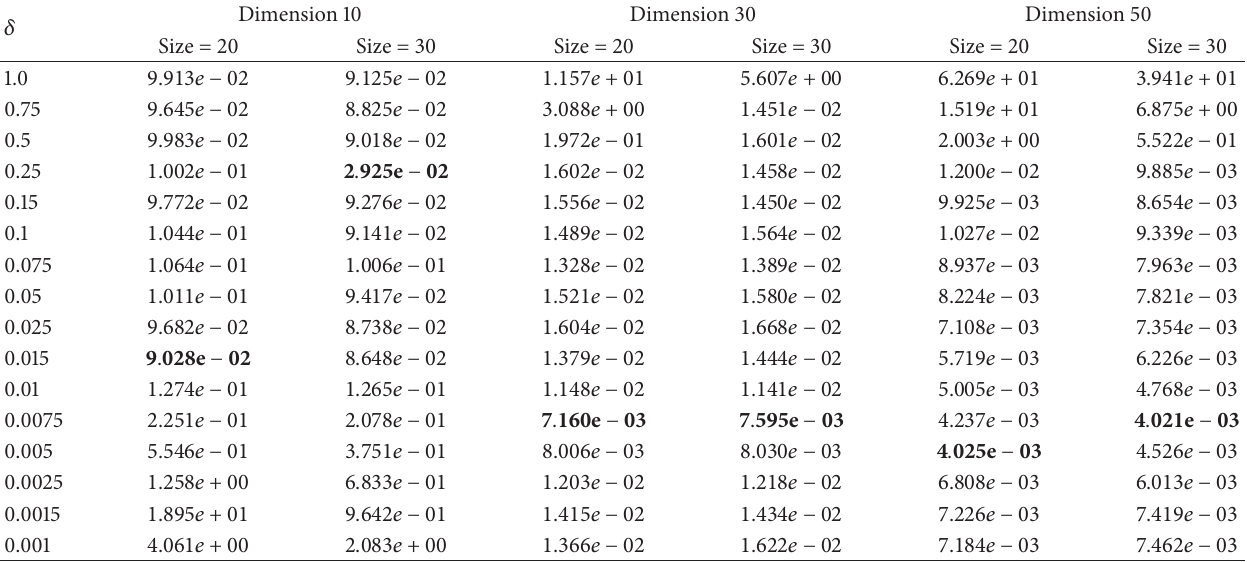
Table 9: Different values of parameter 𝛿 and respective mean best fitness for Griewank test problem.